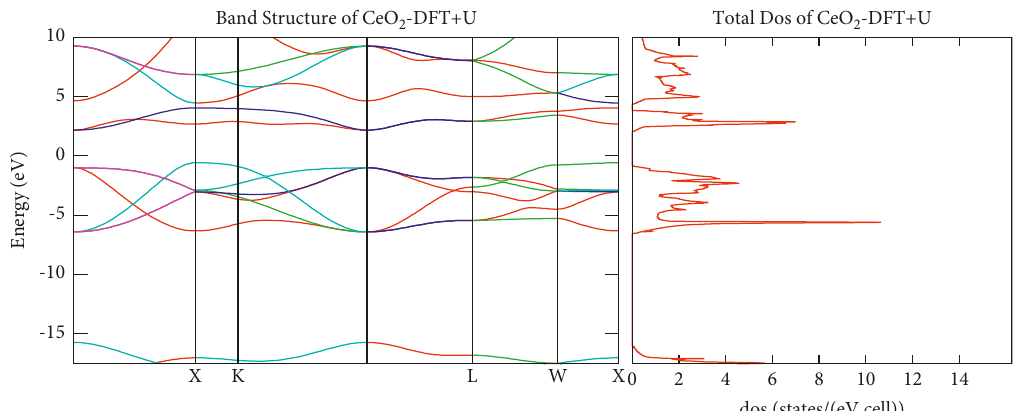
Figure 4: (a) Band structure of CeO 2 and (b) density of states of CeO 2 obtained with DFT+ U approximations.